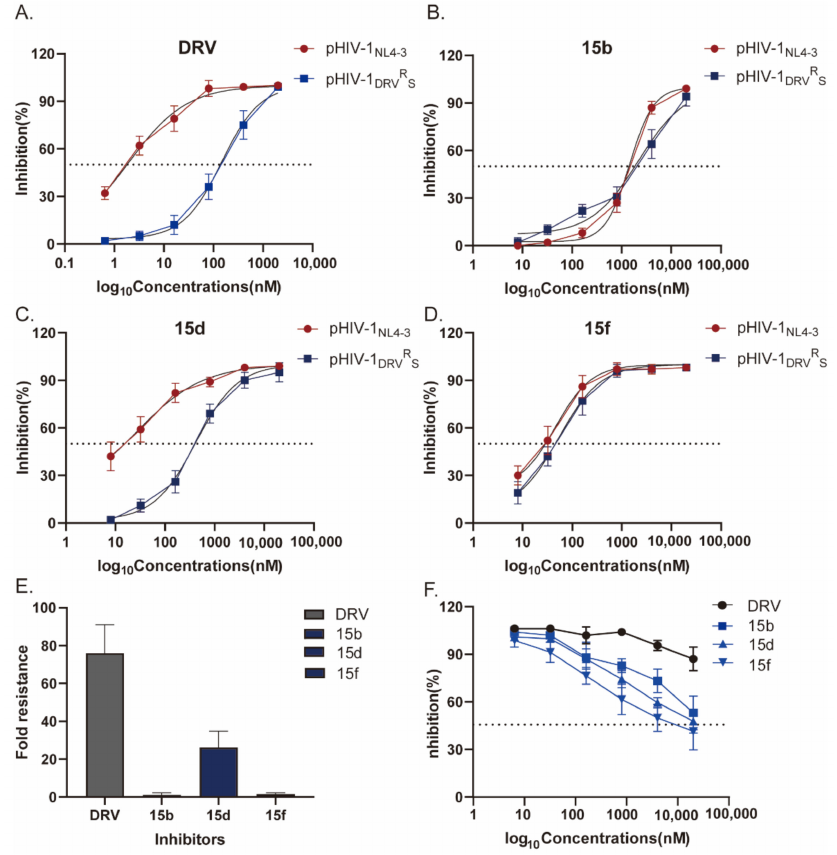
Figure 8. Antiviral activity of 15b , 15d , and 15f against multidrug-resistant HIV-1 variants. ( A – D ) Dose–response relationship of compounds DRV, 15b , 15d , and 15f against WT HIV-1 and DRV-resistant mutant. ( E ) Fold resistance is defined as EC 50 (mutant)/EC 50 (WT). ( F ) 293T cells were treated with these inhibitors as indicated. The CC 50 values were measured with the cell counting kit-8. All assays were conducted in triplicate, and the results shown are the average of three independent experiments; error bars indicate